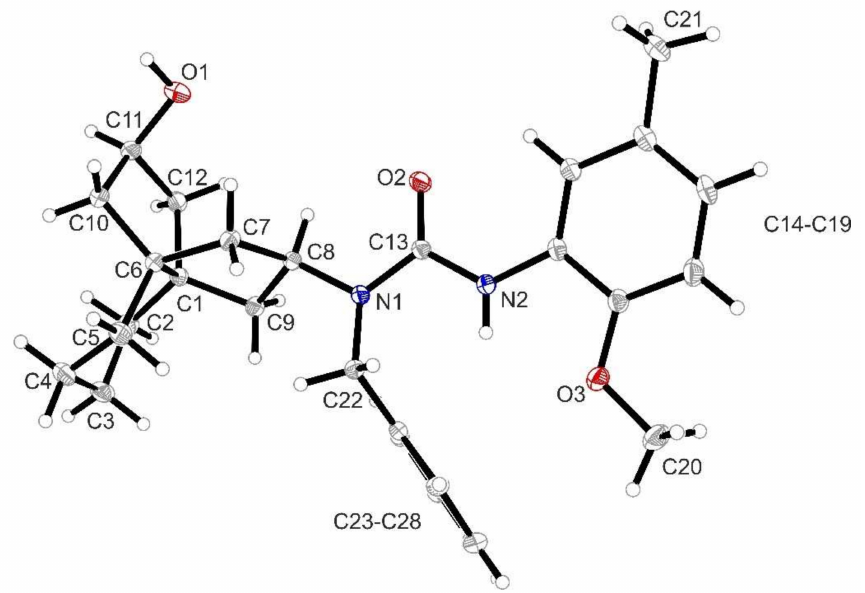
Figure 7. X-ray crystal structure of N -benzyl urea syn,anti - 22 . Thermal ellipsoids are set at 15% probability. Selected bond lengths: C1–C6 = 1.559(2) Å; C1–C2 = 1.535(2) Å; C1–C9 = 1.529(2) Å; C1–C12 = 1.552(2) Å. CCDC number: 2073468.